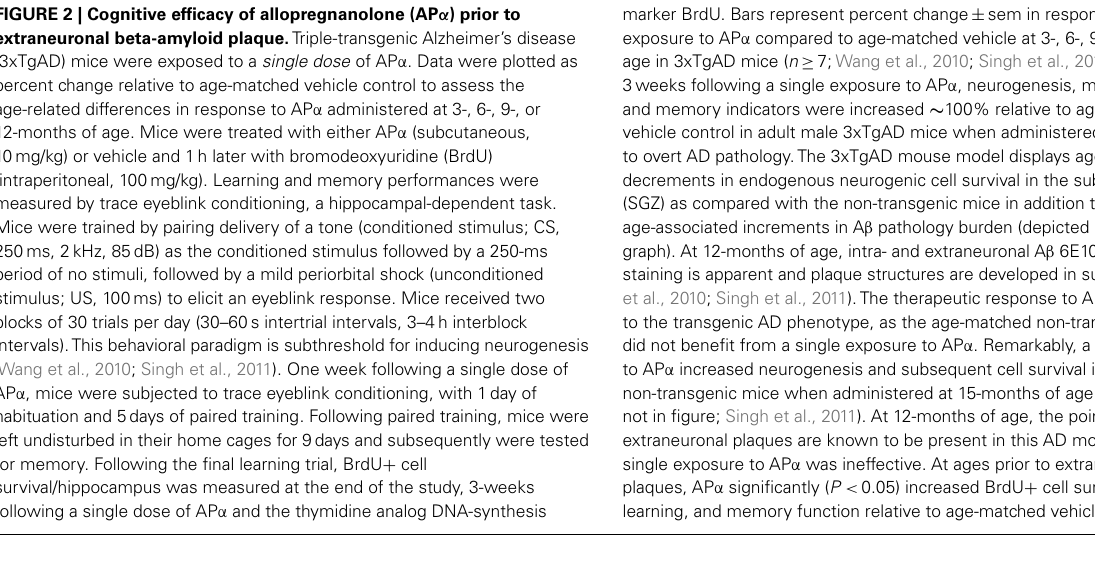
FIGURE 2 | Cognitive efficacy of allopregnanolone (AP α ) prior to extraneuronal beta-amyloid plaque. Triple-transgenic Alzheimer’s disease (3xTgAD) mice were exposed to a single dose of AP α . Data were plotted as percent change relative to age-matched vehicle control to assess the age-related differences in response to AP α administered at 3-, 6-, 9-, or 12-months of age. Mice were treated with either AP α (subcutaneous, 10mg/kg) or vehicle and 1h later with bromodeoxyuridine (BrdU) (intraperitoneal, 100mg/kg). Learning and memory performances were measured by trace eyeblink conditioning, a hippocampal-dependent task. Mice were trained by pairing delivery of a tone (conditioned stimulus; CS, 250ms, 2kHz, 85dB) as the conditioned stimulus followed by a 250-ms period of no stimuli, followed by a mild periorbital shock (unconditioned stimulus; US, 100ms) to elicit an eyeblink response. Mice received two blocks of 30 trials per day (30–60s intertrial intervals, 3–4h interblock intervals).This behavioral paradigm is subthreshold for inducing neurogenesis (Wang et al., 2010; Singh et al., 2011). One week following a single dose of AP α , mice were subjected to trace eyeblink conditioning, with 1day of habituation and 5days of paired training. Following paired training, mice were left undisturbed in their home cages for 9days and subsequently were tested for memory. Following the final learning trial, BrdU + cell survival/hippocampus was measured at the end of the study, 3-weeks following a single dose of AP α and the thymidine analog DNA-synthesis